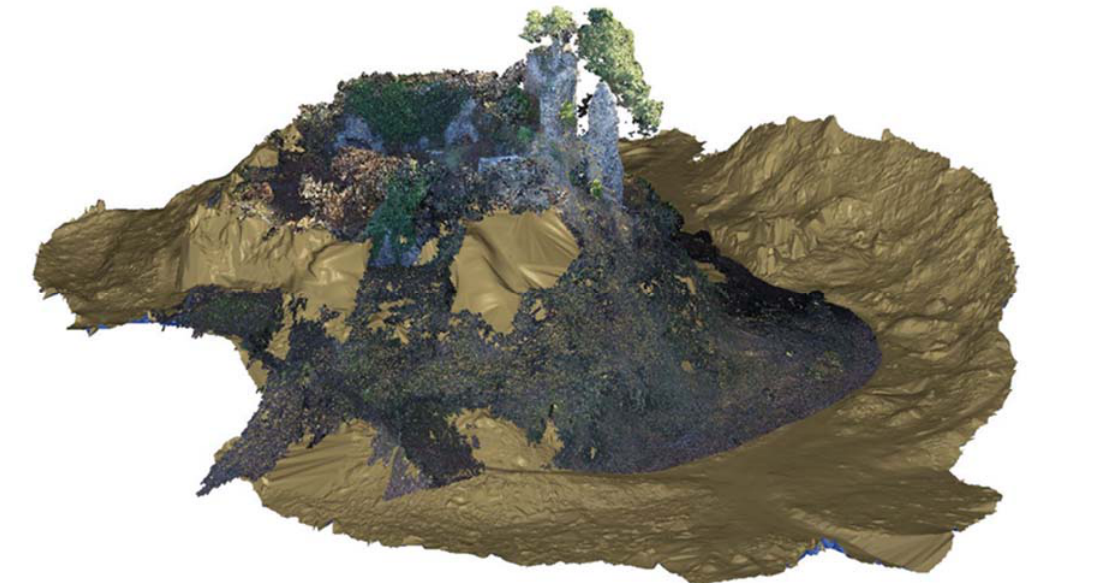
Figure 9: Final DTM with partial ruins